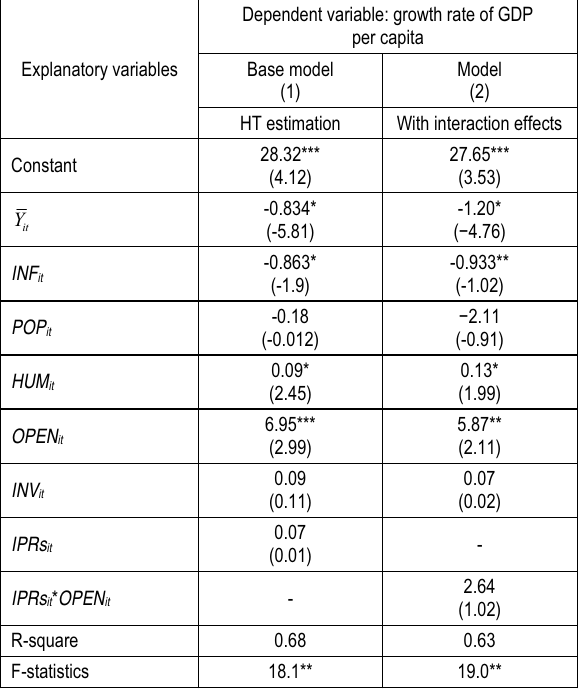
Table 1. Hausman-Taylor estimation